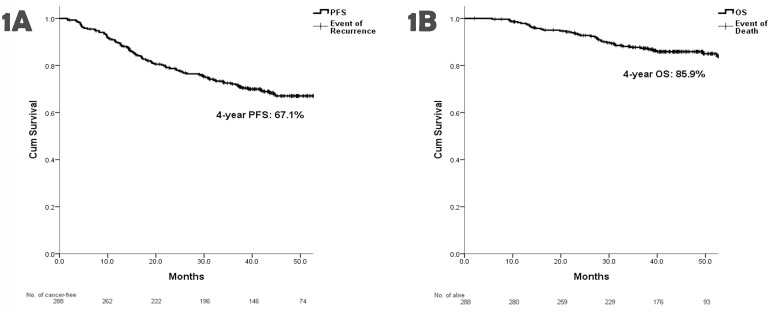
The 4-year PFS and OS.(A) The 4-year PFS was 67.1% and (B) the 4-year OS was 85.9% in all patients.